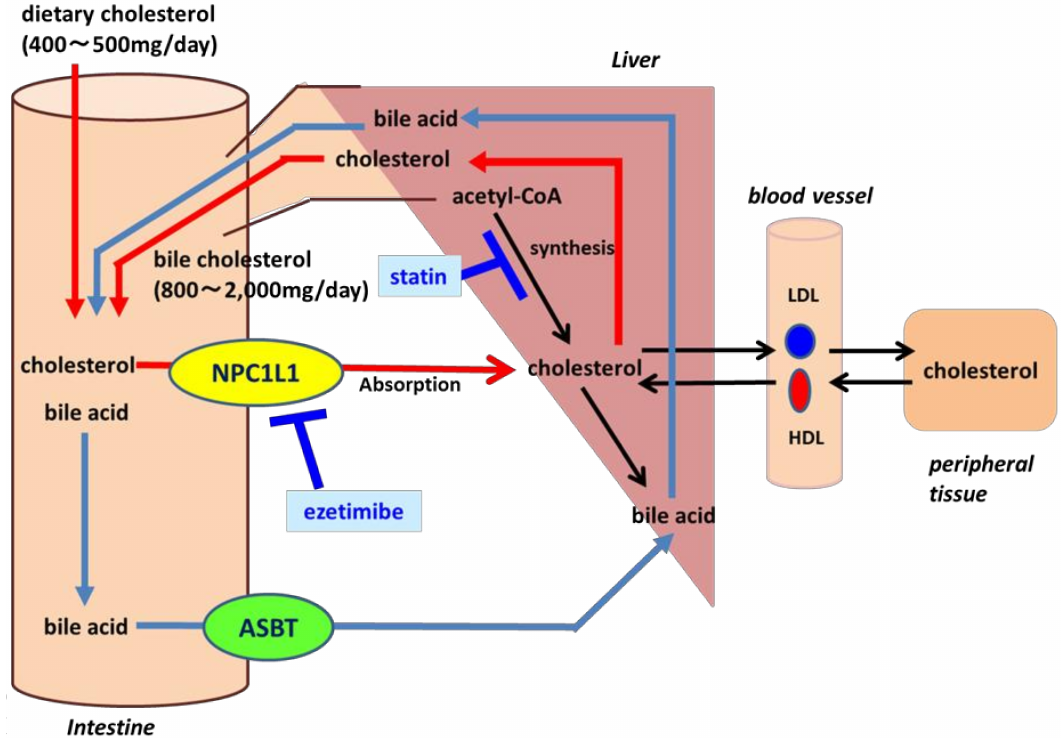
Figure 2. Schematic presentation of blood cholesterol regulation and inhibitory medicines (statin and